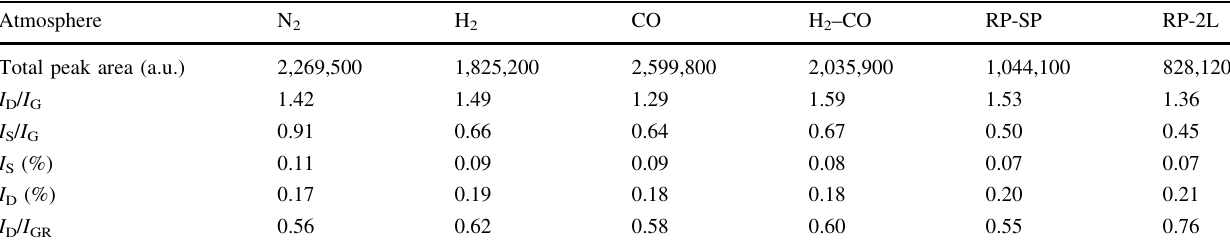
Table 4 Calculation result of deconvolution of a Raman spectrum for the char produced under different atmosphere Atmosphere N 2 H 2 CO H 2 –CO RP-SP RP-2L Total peak area